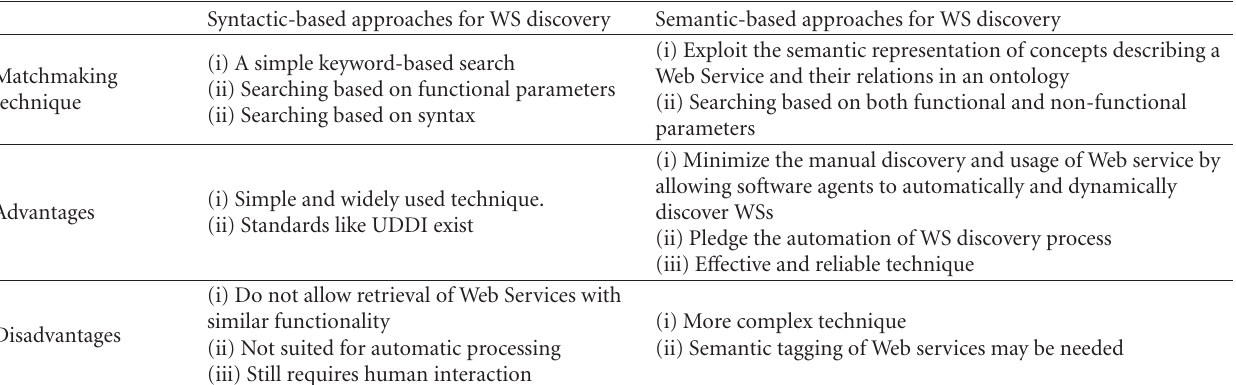
Table 1: Syntactic versus semantic approaches for Web services